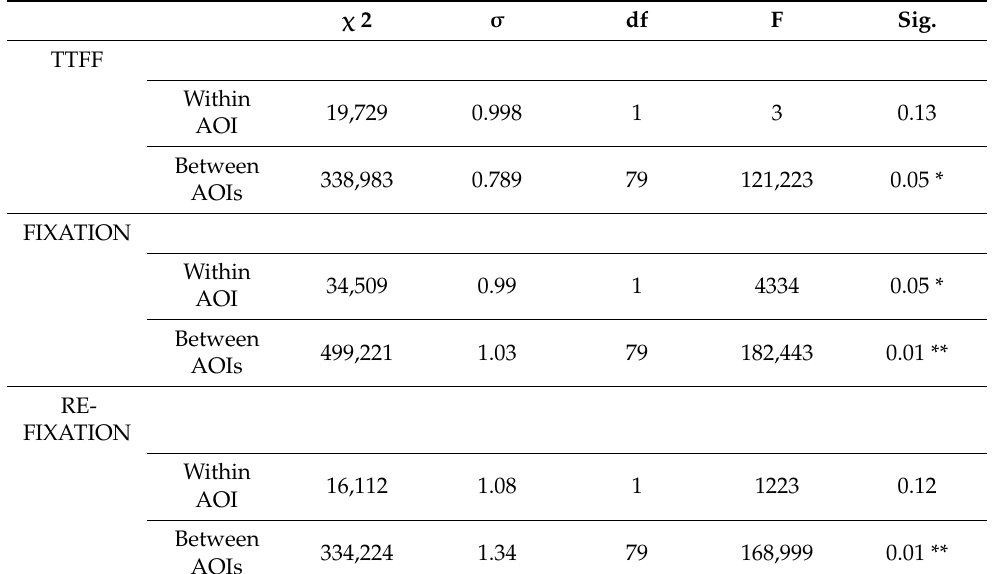
Table 4. AOI 8 ANOVA test S3